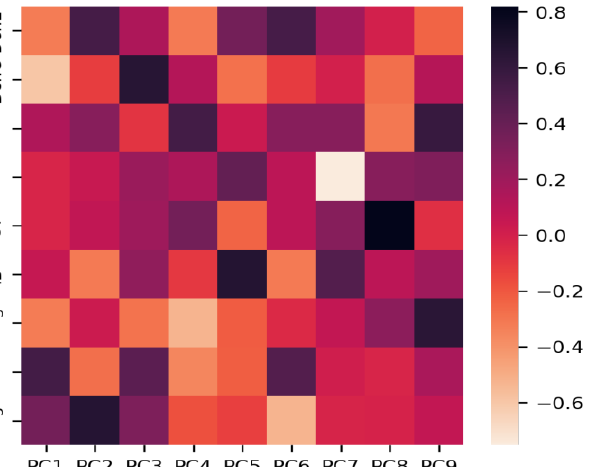
Figure 3. The heat map of principle component analysis of flow-regime features. The correlations between principle components and feature variables are indicated with the color palette in the heat map.